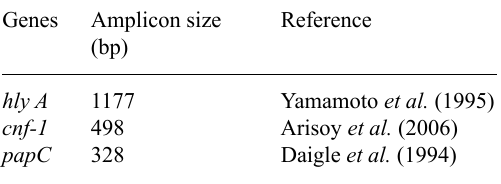
table 2. Expected PCR product size